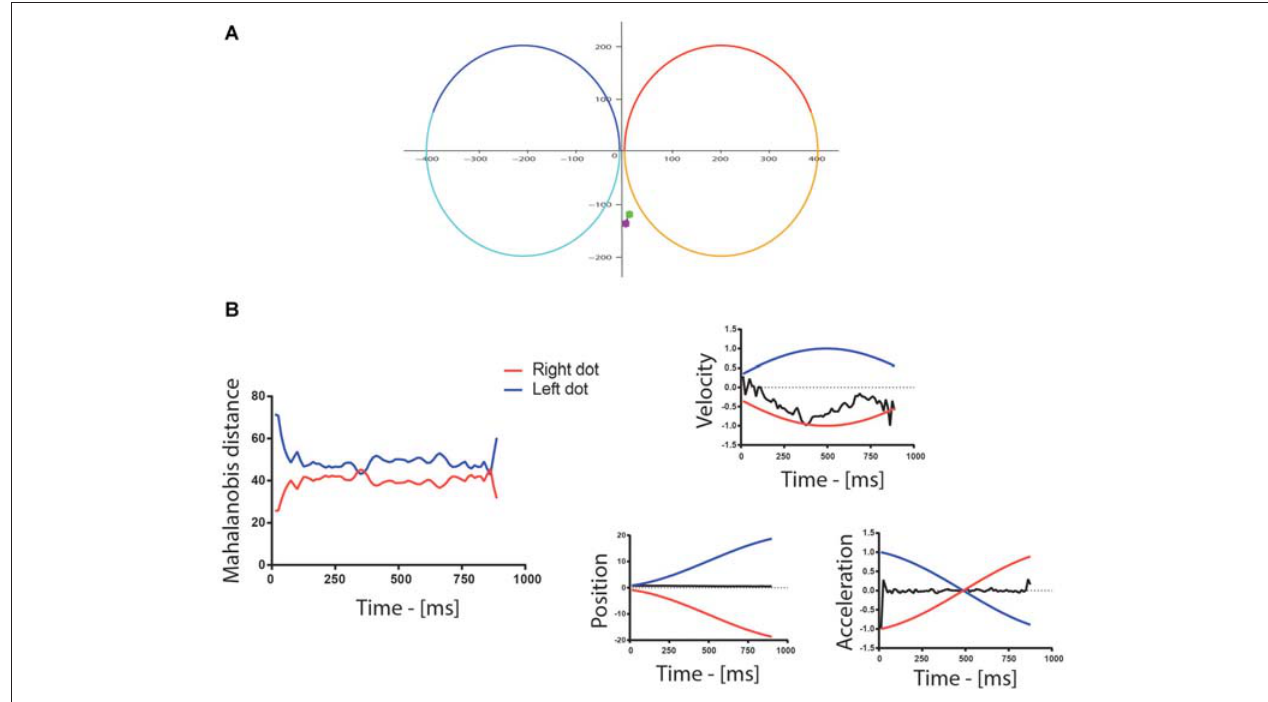
FIGURE 2 | (A) Example of eye movements during a trial: the colored spots represent the beginning (green) and end (purple) of the eye trace. In this particular example, the position of the eyes changed little throughout the trial. The red/orange and the blue/cyan traces are the paths of the two dots for the first/second part of the trial. (B) The graph to the left shows the Mahalanobis distance between the eyes and the dots following the left (blue) and right (red) trajectories/paths in the first half of the trial. The Mahalanobis distance with the two dots was relatively large in this particular trial (around 42) because the position and acceleration profiles of the eyes differed strongly from the ones of the dots, as shown on the graphs on the right of the figure, which illustrate the normalized velocity, the position and the normalized acceleration of the dots (blue—left, red—right) and gaze (black). The position is reported in pixel, whereas the trial-wise normalization of velocity and acceleration was performed by dividing all values by the maximum of their absolute value. The velocity of the gaze, however, followed more closely the velocity of the right dot, which indicated attention allocation to the right in this example trial.